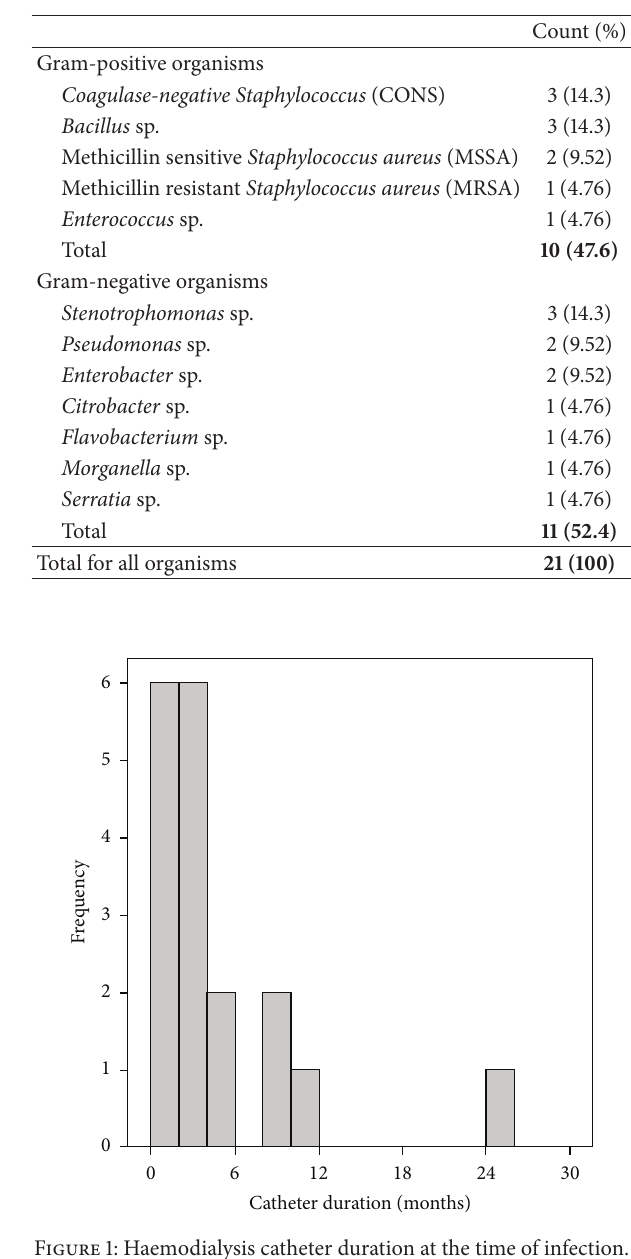
tested with antibiotics upon special request. The number of organisms tested was represented on the antibiogram as the number in parenthesis. Only vancomycin and linezolid were fully efficacious against gram-positive bacteria from the antibiogram. Cloxacillin was only effective against 40% of gram-positive bacteria. Cefepime was the most effective antibiotic with 100% sensitivity against gram-negative organ- isms tested. This was followed by amikacin, ceftazidime, and piperacillin-tazobactam which were effective towards 90% of gram-negative organisms